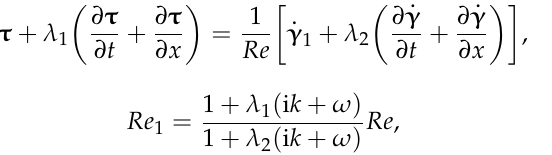
where the subscripts ”sin” and ”var” represent the sinuous (antisymmetric) mode and the varicose (symmetric) mode, respectively. The two modes exist at the same time for the sheet instability, and their final expressions are as